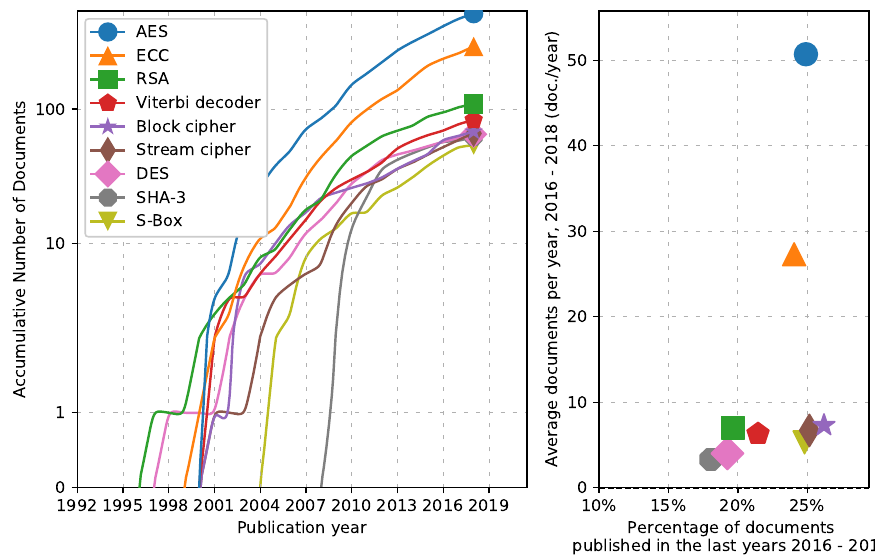
Figure 8. Cryptography top implementations in FPGA